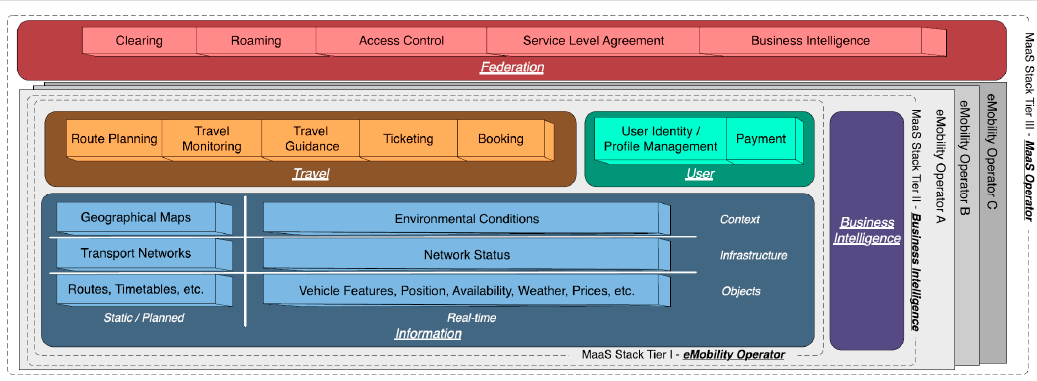
Figure 6. The MaaS stack. Reproduced from Callegati et al. [24].